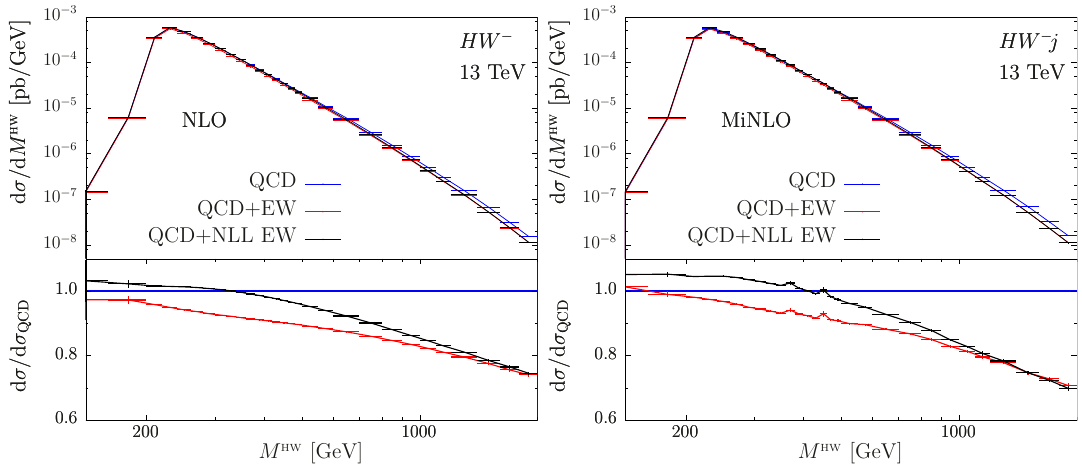
Figure 3. NLO predictions for the invariant mass of the HW (cid:0) pair in HW (cid:0) (left) and HW (cid:0) j (right) production. Shown are predictions at NLO QCD (blue), NLO QCD+EW (red) and at NLO QCD+NLL EW (black). In the lower panel we plot the ratio with respect to NLO QCD.